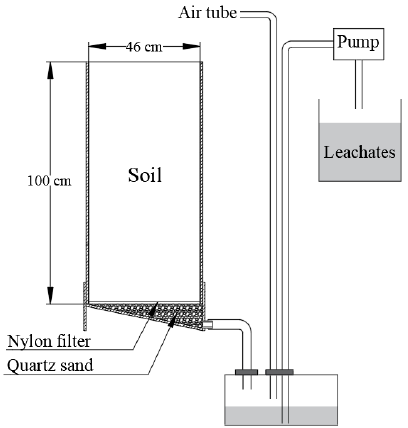
Figure 1. Diagram of in situ soil column leachate-collection